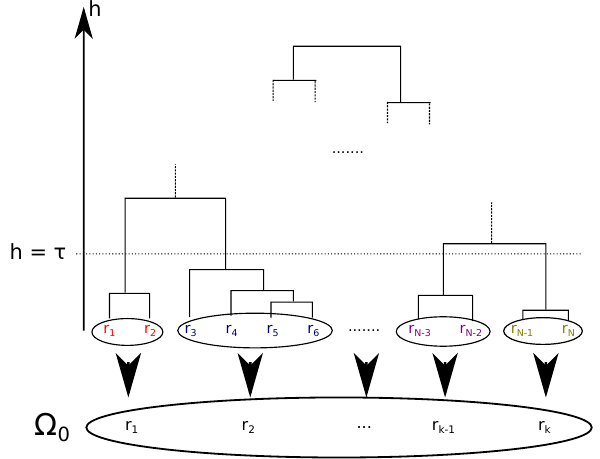
Figure 1. Schematic dendrogram for illustration of steps 4 and 5 of the spatio-temporal clustering